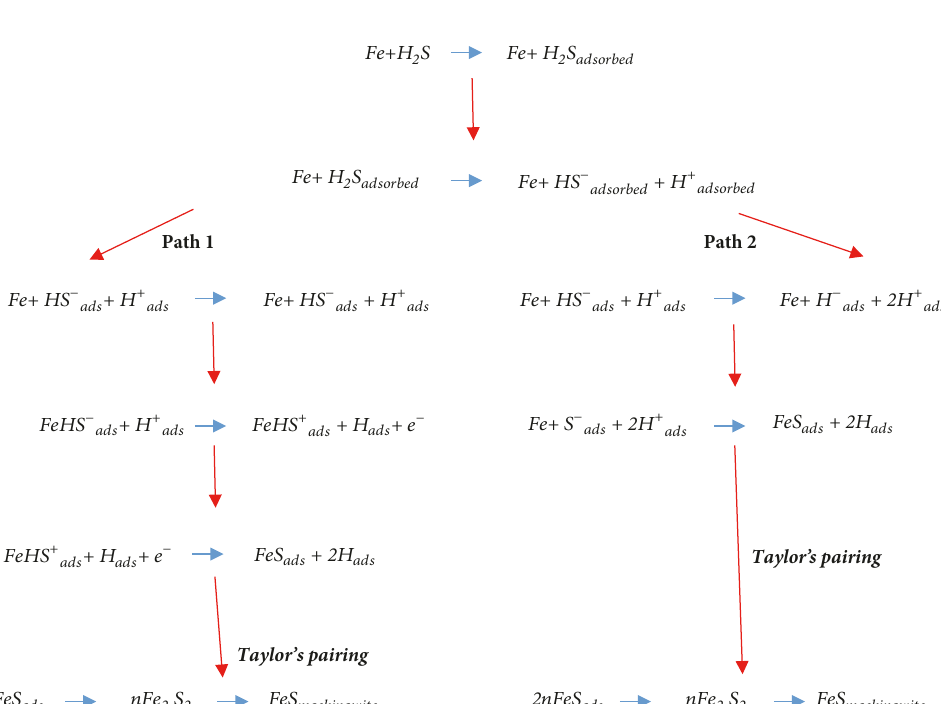
Figure 1: Mild steel corrosion regimes in CO 2 /H 2 S environments.